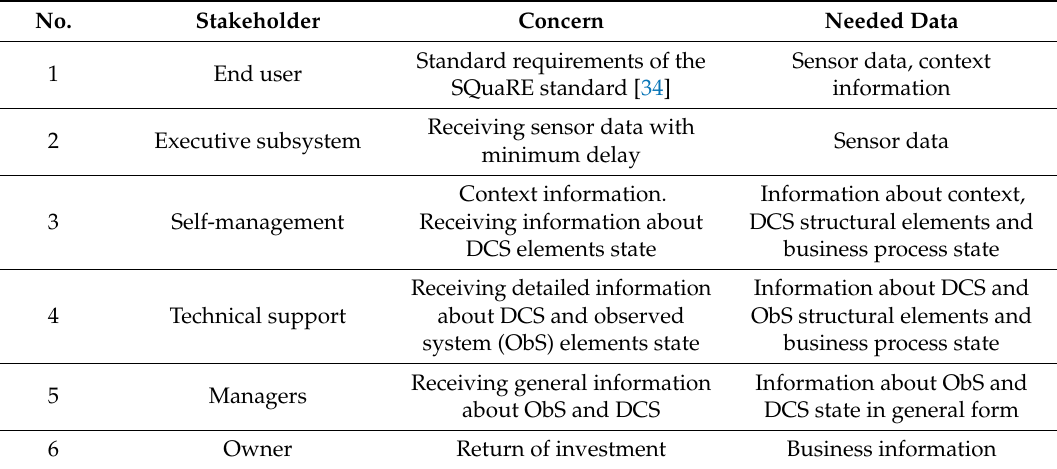
Table 1. Key stakeholders and their concerns.